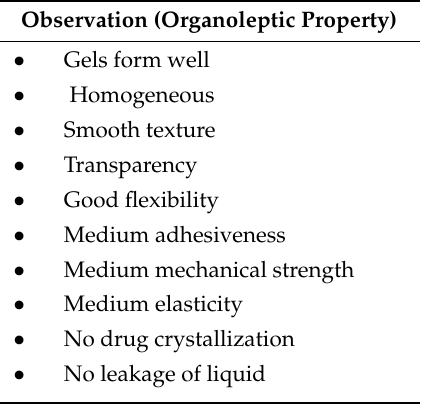
Table 3. Characteristics of optimized hydrogels according to visual